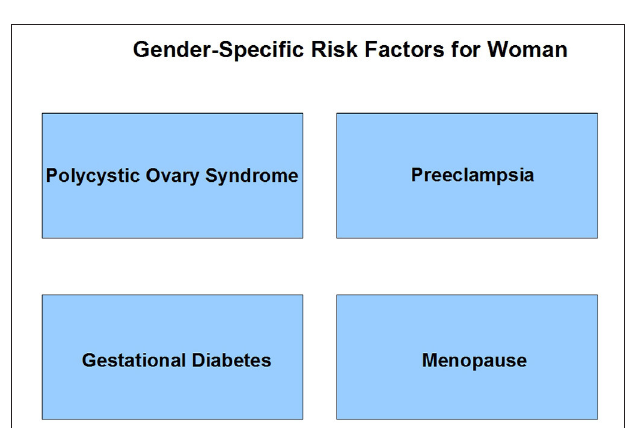
FIGURE 2 | Risk factors specific for